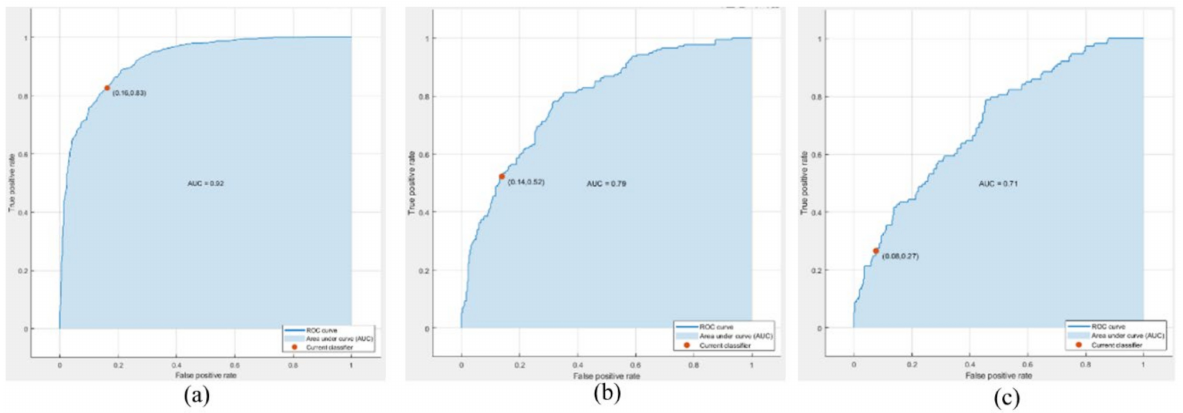
Figure 8. Proposed model training time (s) and prediction speed (obs/s) on mixed views of MIT dataset utilizing 1000- feature subset. The best ROC outcomes on MIT dataset are presented in Figure 9.